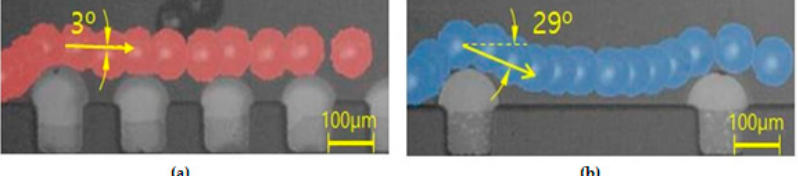
Figure 9. Attack angle on the successive air bubble for the different intervals: ( a ) the interval of the successive air bubble of 100 μ m and ( b ) the interval of the successive air bubble of 500 μ m.